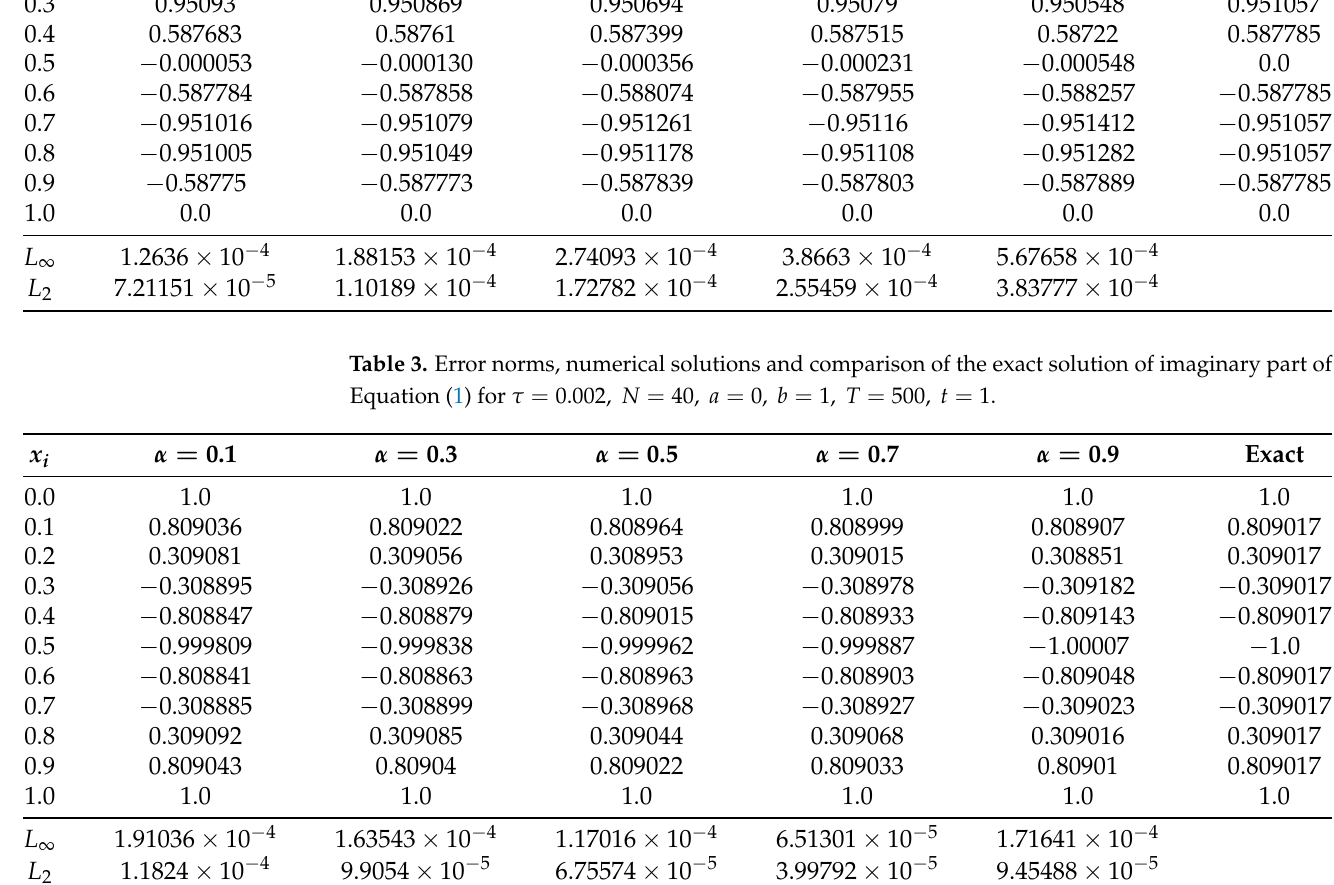
Table 4. Error norms of real part of Equation (1) for τ = 0.005, N = 78, a =